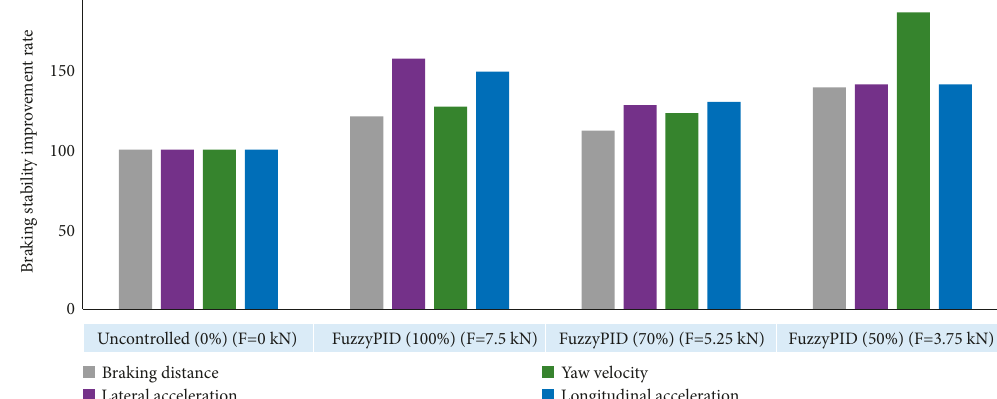
Figure 25: Fuzzy PID control in different braking efficiency